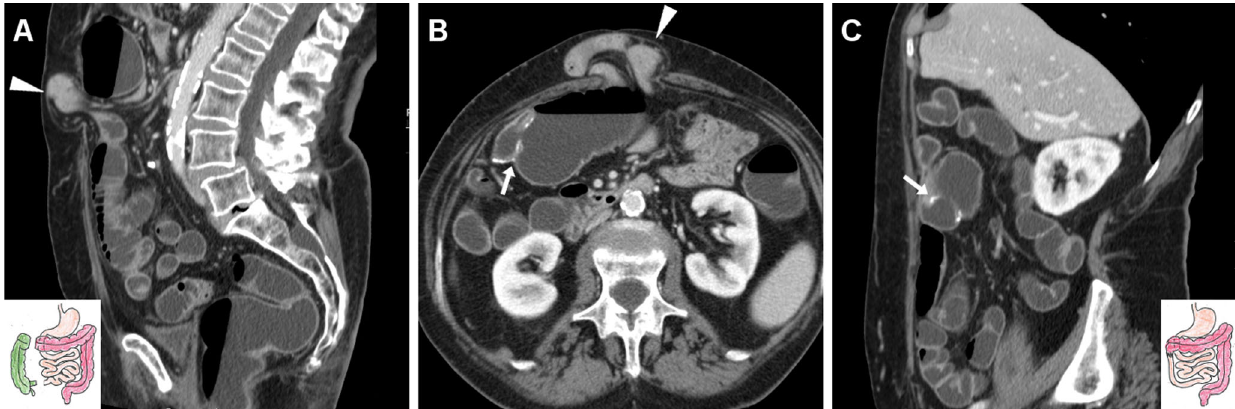
Fig.4 Expected statusafter right hemicolectomy (surgical scheme shown in insets) for carcinoma in an 88-year-old female. WE-MDCT showed well-distended residual bowel and patent end-to-side ileo-colic